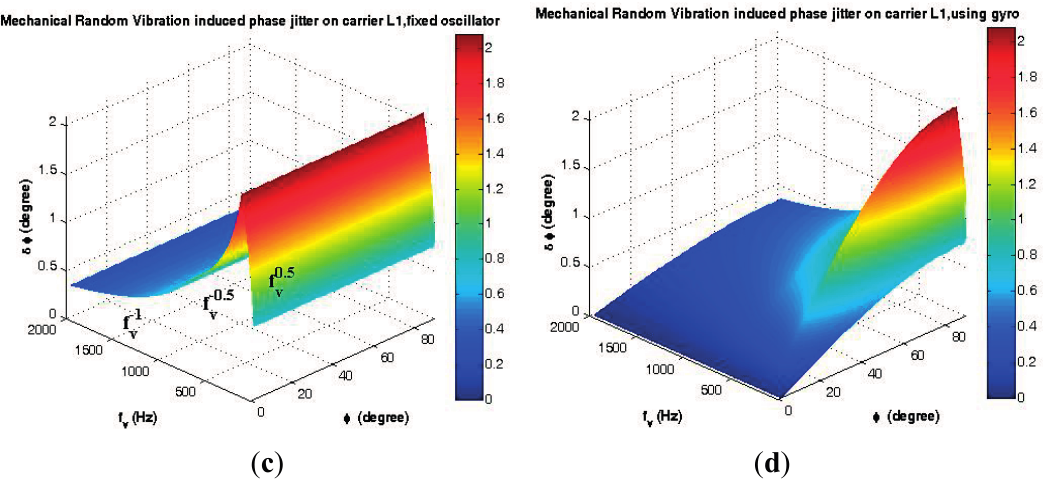
Figure 20. Analysis of the maximum mechanical random vibration in the frequency domain for β = 0 and ξ = φ . ( a ) Frequency jitter of a fixed oscillator; ( b ) Frequency jitter of the gyroscopic mounting; ( c ) Phase jitter of a fixed oscillator; ( d ) Phase jitter of the gyroscopic mounting.